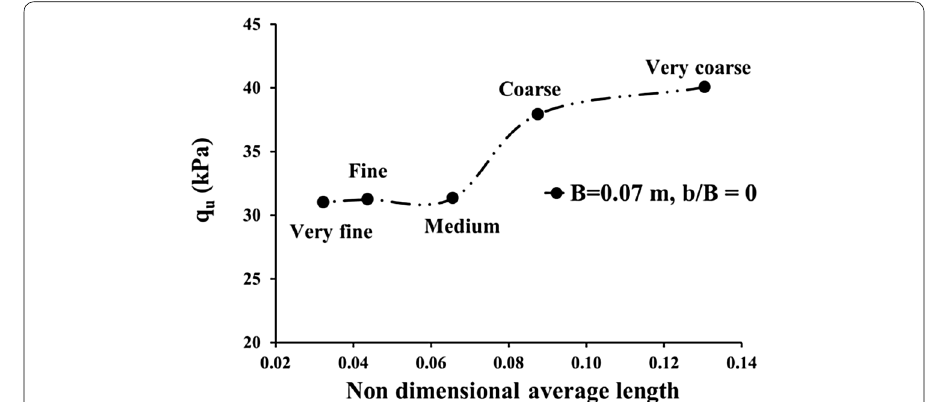
Fig. 6 Convergence study for determining the optimum mesh